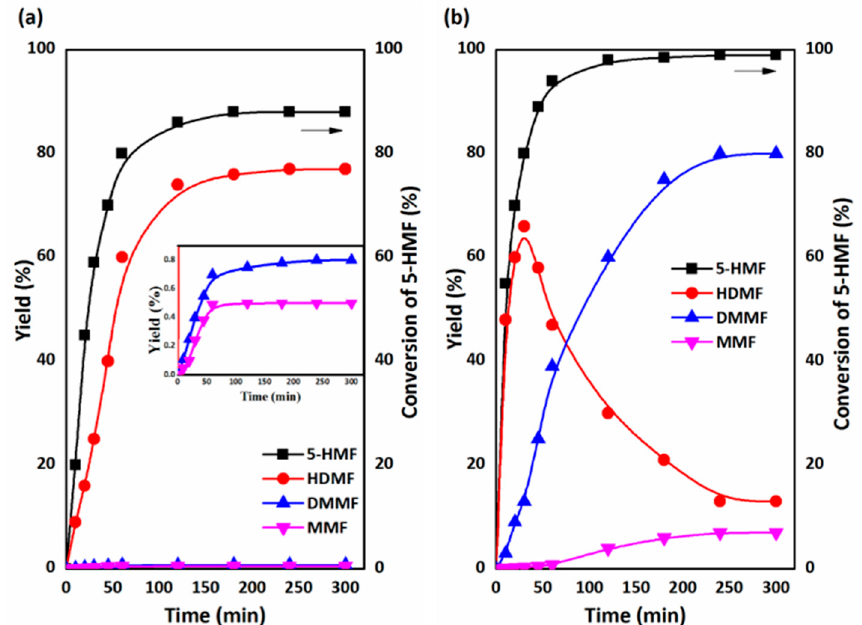
Figure 1. Acetalization of 5 ‐ Hydroxymethylfurfural (5 ‐ HMF) in methanol. ( a ) 0.77 mmol 5 ‐ HMF in 4.0 mL of methanol at 60 °C with 26 mg of SiO 2 ‐ HNO 3 . ( b ) 0.77 mmol 5 ‐ HMF in 4.0 mL of methanol at 120 °C with 26 mg of SiO 2 ‐ HNO 3 . (Inset: details for 5 ‐ HMF, 5 ‐ (hydroxymethyl) ‐ 2 ‐ (dimethoxymethyl) furan (HDMF), 2 ‐ (dimethoxymethyl) ‐ 5 ‐ (methoxymethyl) furan (DMMF), and 5 ‐ (methoxymethyl) ‐ 2 ‐ furaldehyde (MMF) with yields in the range from 0% to 0.8%).